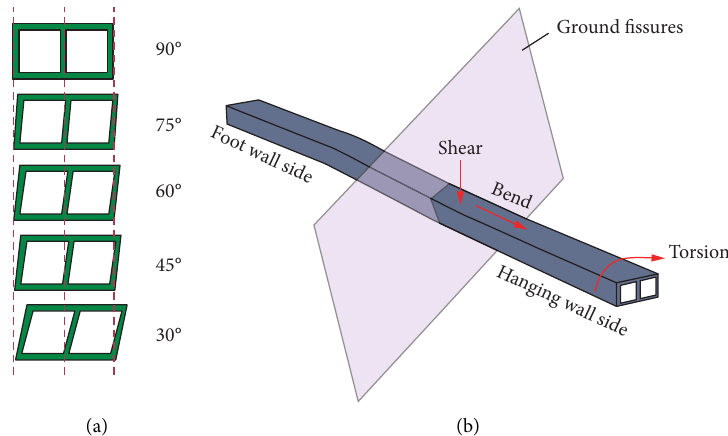
Figure 9: The deformation of the utility tunnel. (a) The trend of horizontal displacement in section with different intersection angle. (b) 3D illustration of the mechanism of deformation of utility